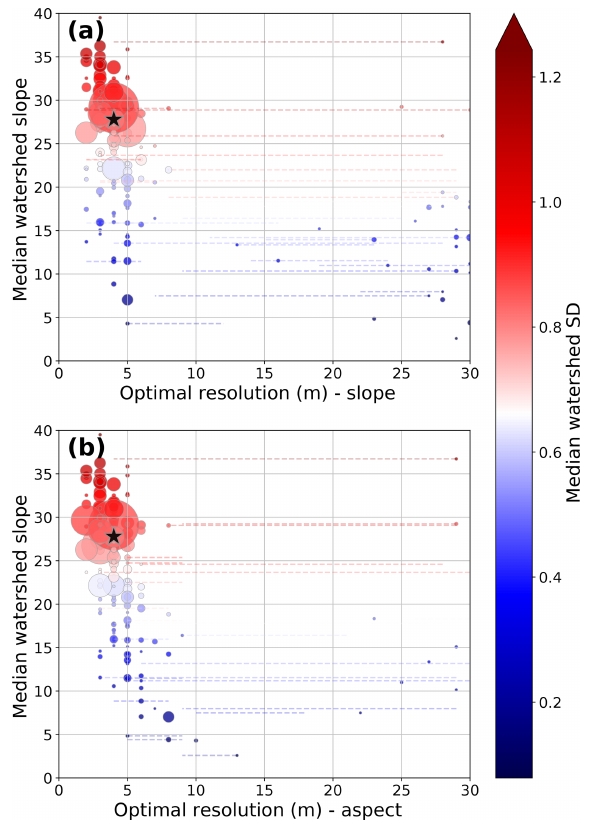
Figure 12. Optimal grid resolution for minimizing error bounds on slope and aspect calculations across SCI compared to catchment median slope. Point sizes are scaled to catchment size, from 0.1 to 34km 2 . Dashed lines show the 25th percentile to 75th percentile of optimal grid resolution, colored by the standard deviation of that point. Stars show the whole-island optimal resolution and median slope. There exists a clear trend where lower median slopes lead to lower optimal grid resolutions. Standard deviations also tend to be smaller in these catchments, due to higher DEM fidelity over flat terrain. Catchments with low ( > 10m) optimal grid resolutions are small and have complex topography. For a map view of these results, we refer to Fig.